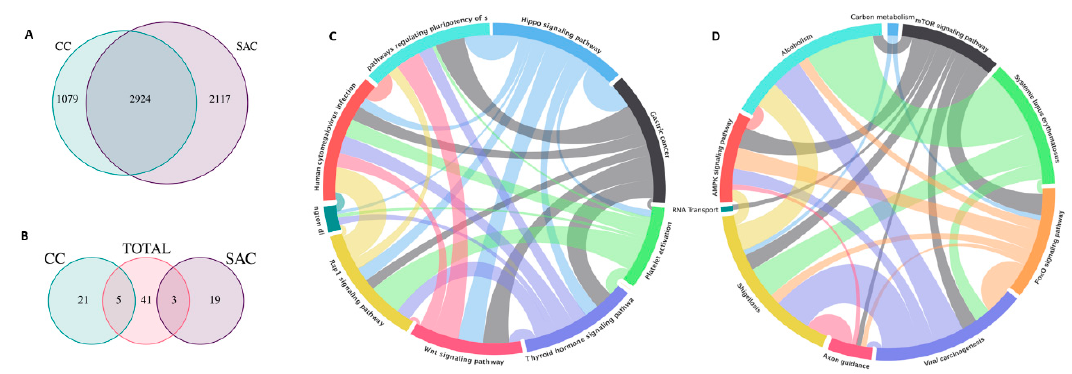
Figure 2. Di ff erentially enriched functions in the SAC and CC transcriptomes. ( A ) Venn diagram displaying the number of common genes up- or down-regulated in SAC and CC compared to normal adjacent mucosa. Di ff erential expression analysis has been performed on normalized data with the Linear Models for Microarray Data (Limma) package by Bioconductor [29]. Using Limma, two comparisons were made between 5 normal and 12 CC samples and the same 5 normal and 13 SAC samples. ( B ) The Kegga method from Limma was used to perform this analysis, which obtained 49 pathways significantly enriched for shared di ff erentially expressed genes in both groups: 26 pathways for CC (5 of them shared) and 22 pathways for SAC (3 of them shared). As expected, there were no shared pathways between the di ff erent genes of the groups CC and SAC. For the false discovery rate (FDR), the Benjamini and Hochberg method was used to get corrected p -values [30]. Di ff erentially enriched functions in CC ( C ), including Wnt-signalling and in SAC ( D ), including those lifestyle-, neural-, immune-hypoxia-related ( D ) are shown. The VEGF signalling pathway was close to significance in SAC, with 7 di ff erentially expressed genes (MAPKAPK3, VEGFA, PIK3R2, RAF1, PLA2G4C, PPP3CB and PRKCB) and some related hypoxia-associated pathways (AMPK and mTOR signalling). FSCN1 is di ff erentially expressed in the comparison Normal vs. SAC, but it is not in Normal vs.